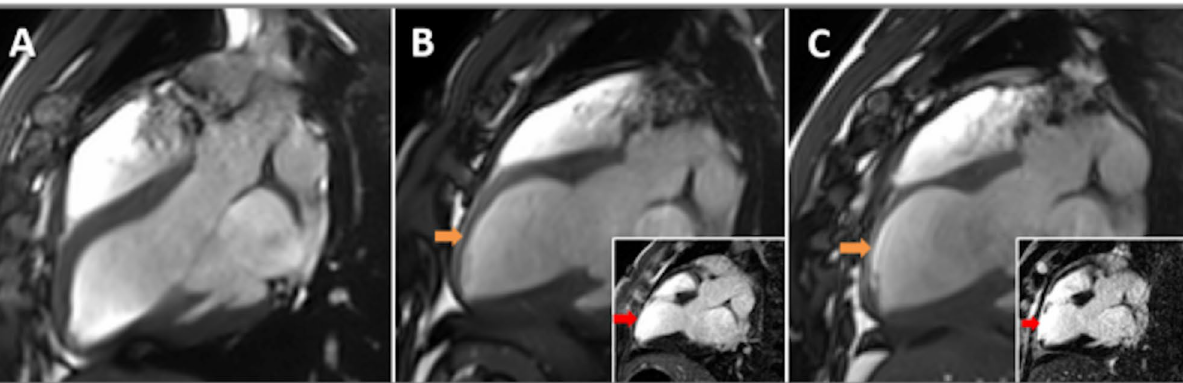
Figure 2. Representative longitudinal CMRI imaging of failing Left Ventricle. From left to right showing CMRI images from the same animal at baseline ( A ), acute ( B ) and chronic ( C ) time-points. Large images show stills of cinematic imaging in 3-chamber view orientation at end diastole demonstrating progressive thinning of the mid to apical antero-septal wall (orange arrows). Inset images show corresponding late gadolinium enhancement imaging demonstrating full thickness late gadolinium enhancement (red